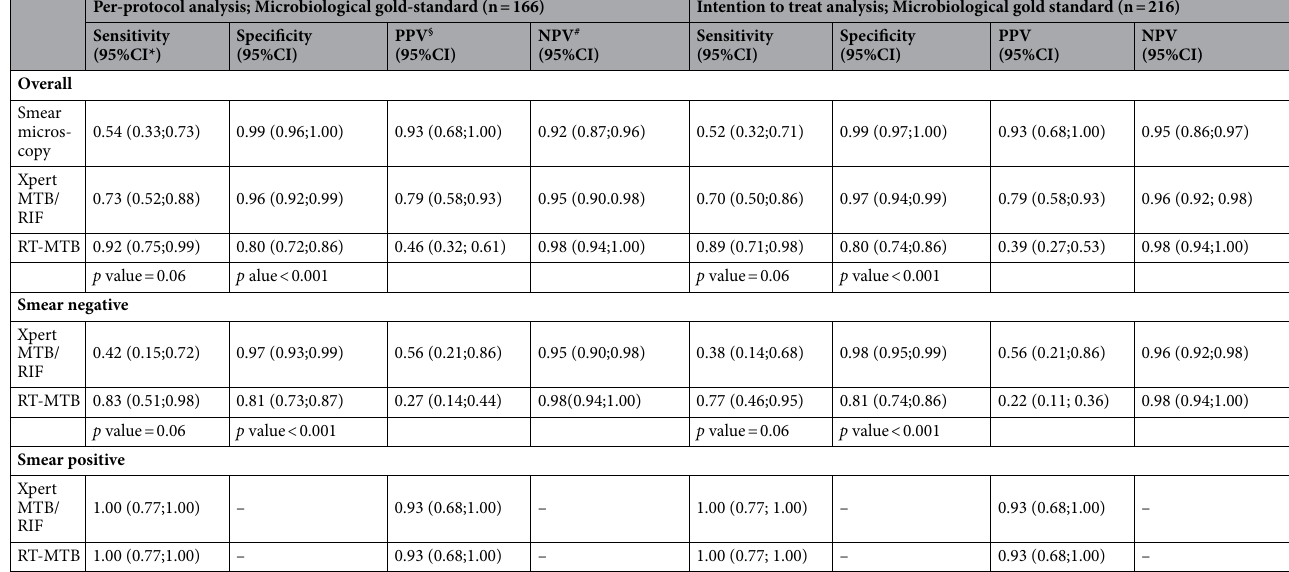
Table 3. Primary analysis. Diagnostic test values using aggregated culture results as the reference standard. Comparison between the per-protocol and the intention-to-treat cohort. * CI confidence interval; § PPV positive predictive value; # NPV negative predictive value.